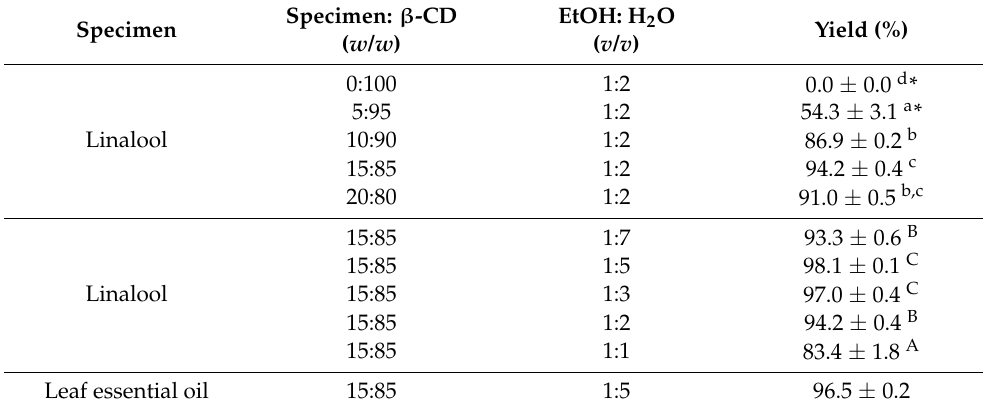
Table 2. Yields of linalool and leaf essential oil microencapsulated with β -cyclodextrin.